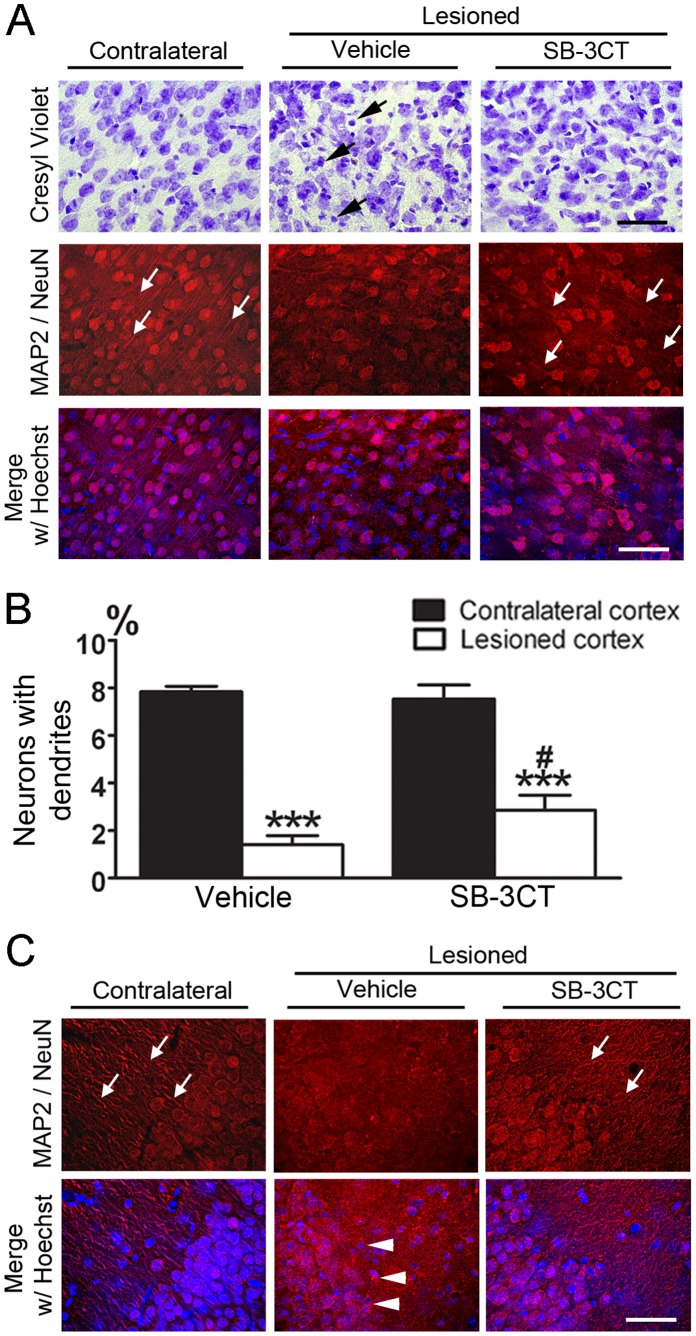
SB-3CT treatment protects cortical and hippocampal neurons from dendritic degeneration at 7 days after TBI.
A. Representative photomicrographs of mouse cortical region in sections stained with either cresyl violet (top row), neuronal markers NeuN and MAP-2 (second row) and merged images with Hoechst dye counterstaining (bottom row) showing neuronal cell death and dendritic degeneration. SB-3CT treatment resulted in less irregular, darker stained neurons compared to the vehicle-treated mice (top row). In addition, more neurons with well-defined dendritic processes (white arrows) were seen in the contralateral cortex compared to the lesioned ones (second row). Scale bar (both black and white) = 50 µm. B. Quantification of neuronal cells with dendrites. Numbers of neurons with dendrites were counted from a total of approximately 800–1000 cells in each hemisphere. A marked difference in the percentage of neurons with dendrites was seen between contralateral and lesioned cortex. The percentage of neurons with dendrites was significantly higher in the lesioned cortex of SB-3CT-treated mice compared to that of vehicle-treated mice; n = 5 for each group; ***, p<0.001, comparing the lesioned to contralateral cortex; #, p<0.05, comparing the difference between the contralateral and lesioned cortex after SB-3CT treatment to that in vehicle-treated animals using a one-tailed, unpaired Student’s t-test. Data are expressed as mean ± SEM. C. Comparison of dendritic degeneration in the lesioned and contralateral CA3 subregion of the hippocampus. Neuronal cells in the lesioned CA3 appear in condensed, irregular shape (white arrowheads), while cell bodies in the contralateral region as well as after SB-3CT-treatment appear intact in round shape with dendritic processes (white arrows), indicating that SB-3CT protects against dendritic degeneration from traumatic insult. Scale bar = 50 µm.